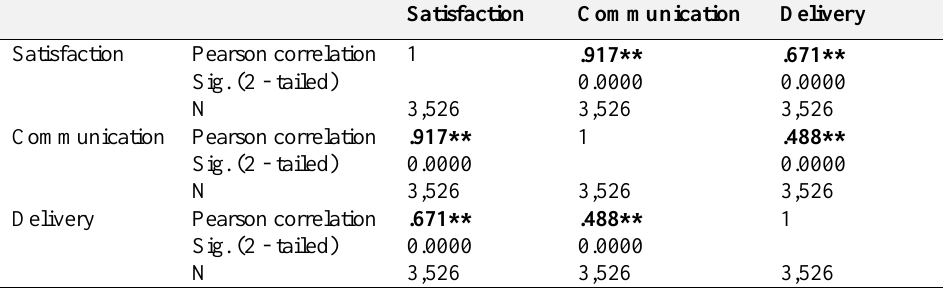
Table 8 – Pearson’s correlation E-shops in CZ